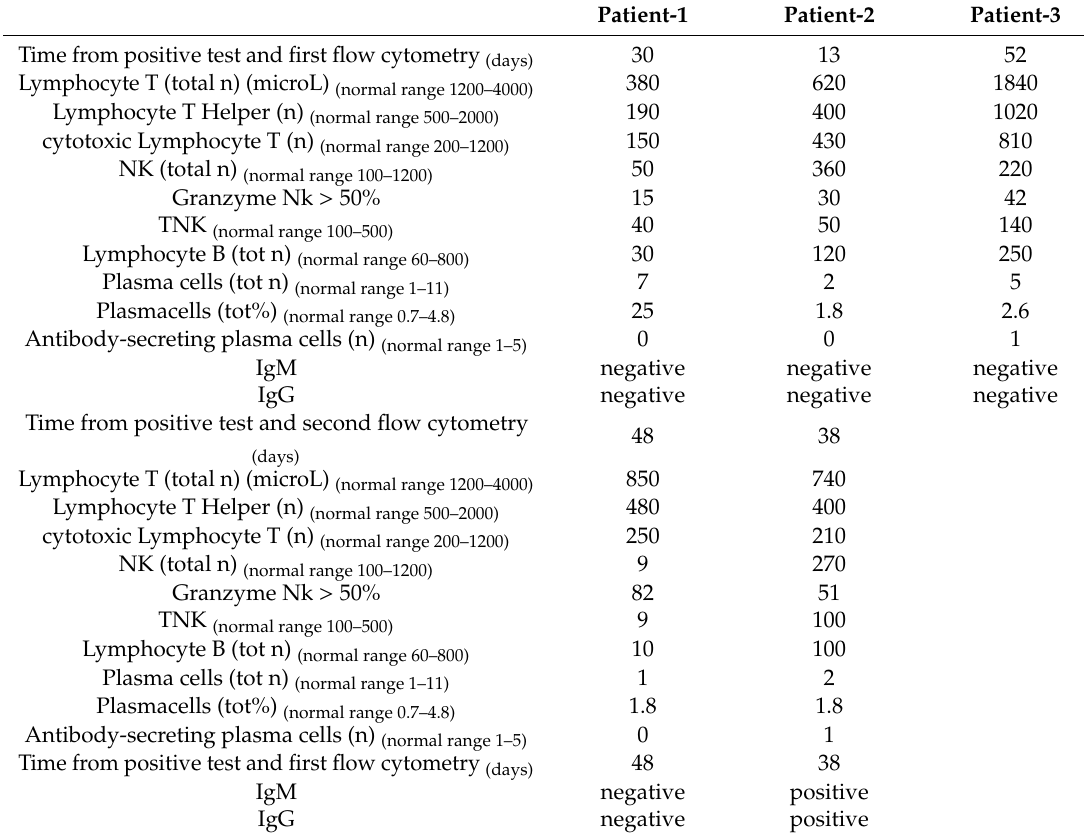
Table 2. Flow cytometry variables of the three